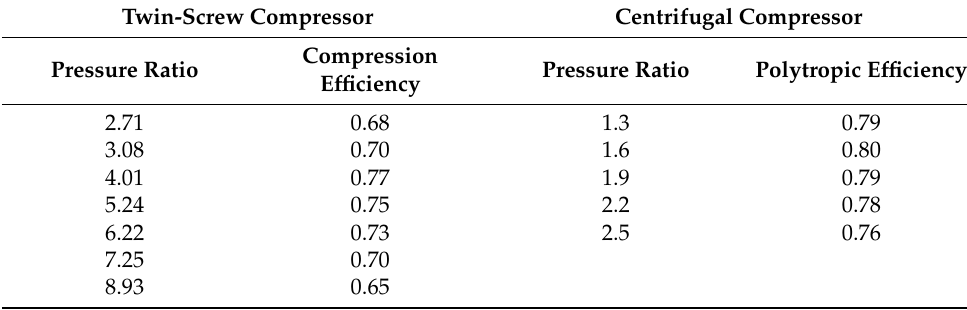
Table 1. Efficiency of vapor compressor.